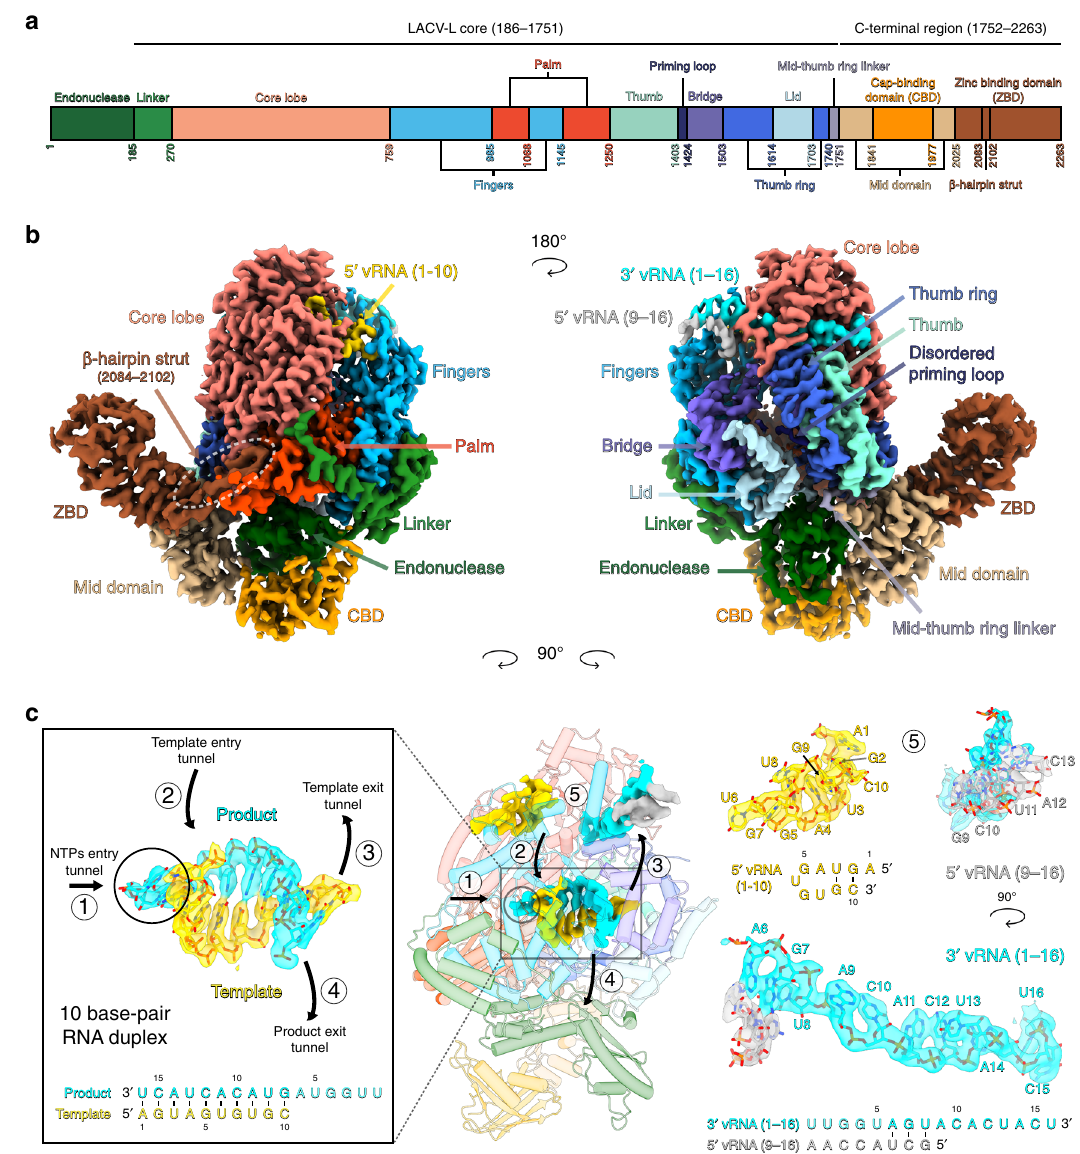
Fig. 1 Cryo-EM structures of LACV-L FL. a Schematic representation of LACV-L FL domain structure. b Two views of LACV-L FL cryo-EM map at pre- initiation stage. A composite cryo-EM map was assembled from individual maps of the (i) LACV-L core, endonuclease and mid domain, (ii) mid domain and CBD, and (iii) mid domain and ZBD. Domains and RNAs are indicated with arrows and colored as in a . c Cartoon representation of semi-transparent LACV-L FL cryo-EM structure at elongation-mimicking stage rotated of 90° compared to b . Close-up views of the Coulomb-potentials and models of all RNAs visible in the elongation-mimicking map. The position of the four tunnels are shown and numbered from 1 to 4. The 5 ′ end vRNA (1 – 10) in its “ 5 ′ end stem-loop loop pocket ” is displayed in yellow, the 3 ′ vRNA (1 – 16) in its “ 3 ′ end pre-initiation pocket ” is shown in cyan, the 5 ′ vRNA (9 – 16) that hybridizes with the 3 ′ vRNA (1 – 16) is colored in light gray. The RNA that mimics the template and product are shown in yellow and cyan, respectively. The sequence and secondary structures of nucleic acid moieties in each complex are